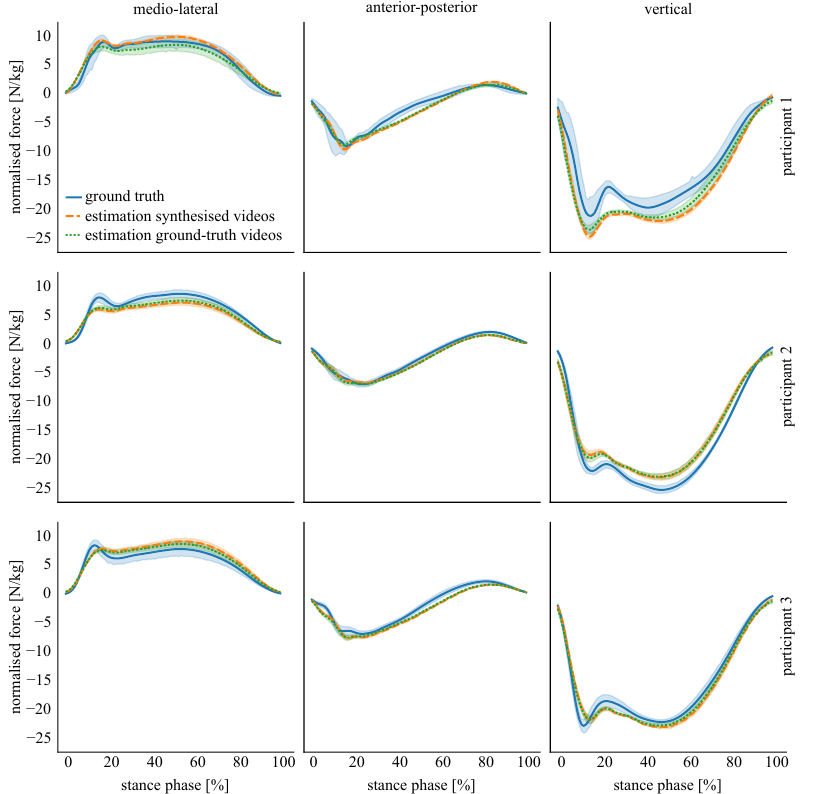
Figure 10. Estimation of the single GRF components for the three validation participants of Phase A. The solid lines represent the mean value and the shaded area the standard